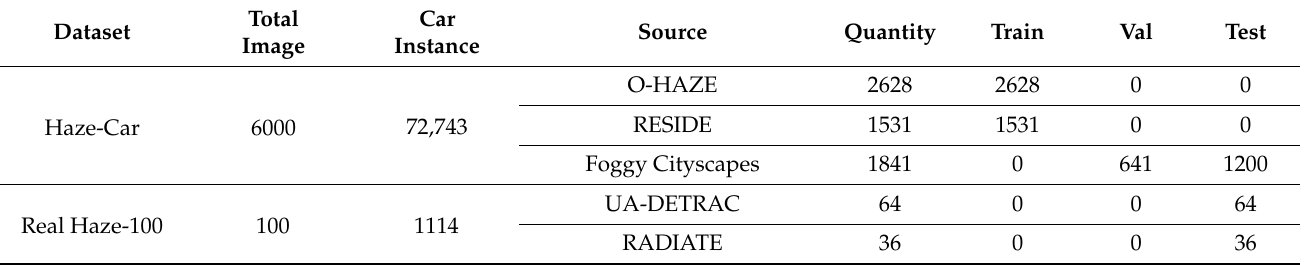
Table 1. Dataset